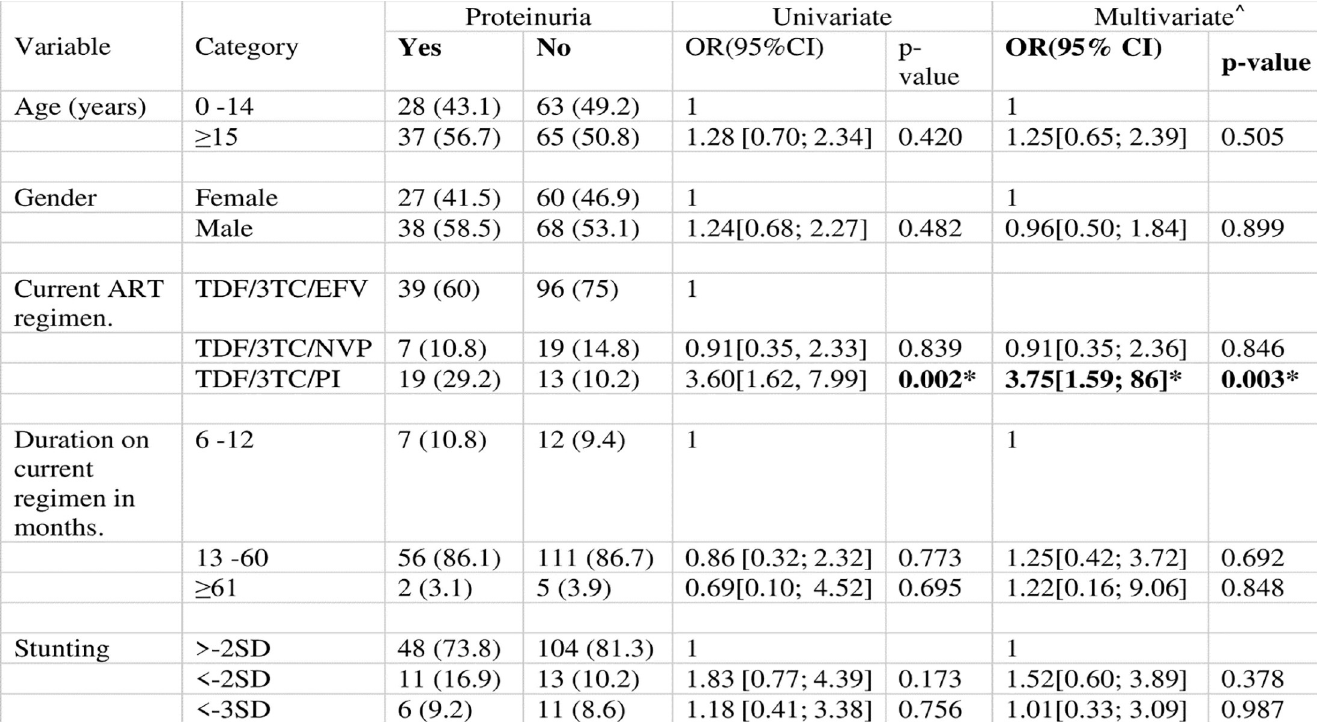
Fig 1. Factors associated with proteinuria in HIV infected children, on TDF for at least 6 months, < 18 years old, (n = 193) † . Children less than 18 years who weighed at least 25 kg and were on a TDF based regimen for at least six months were eligible for the study. Participants with pre-existing diabetes or hypertension were excluded from the study. A urine deep stick proteinuria followed by confirmatory urine protein: creatinine ratio to confirm proteinuria was performed for the participants. † 6 samples not be processed due to a technical fault at the laboratory. � Statistically significant at α = 0.05. ^ Only current ART regimen and stunting had p- value less than 0.25 in the univariate analysis. However, all variables were included in the multivariate analysis to control for any confounding effects from these variables.